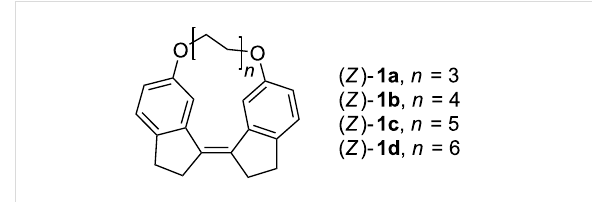
Figure 1: The investigated SS-macrocycles ( Z )- 1a – d